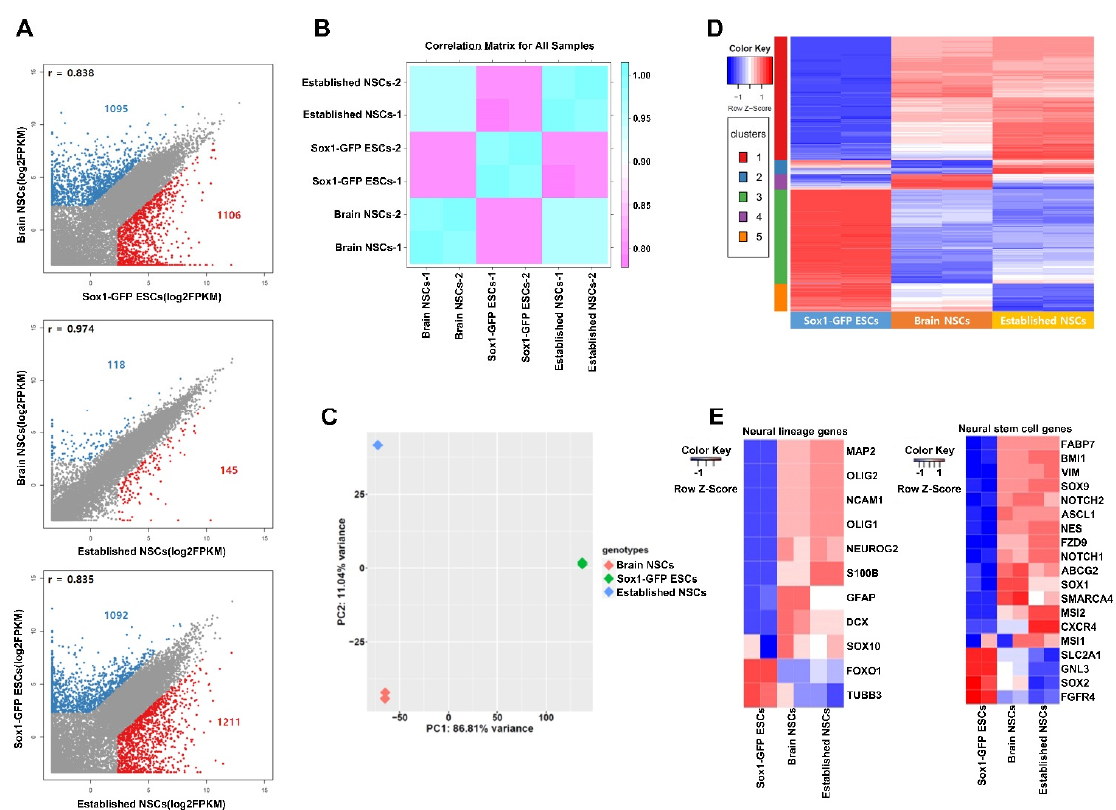
Figure 4. Transcriptome analysis of three cell lines: established NSCs, brain NSCs, and Sox1 -GFP ESCs. ( A ) Scatterplot analysis of three cell lines. ( B ) Correlation matrix analysis of three cell lines. ( C ) Principle component analysis (PCA) of bulk RNA-seq data from three cell lines. ( D ) Heatmap clusters of DEGs between three cell lines. ( E ) Heatmap of lineage-specific gene expression in neural cells and neural stem cells.